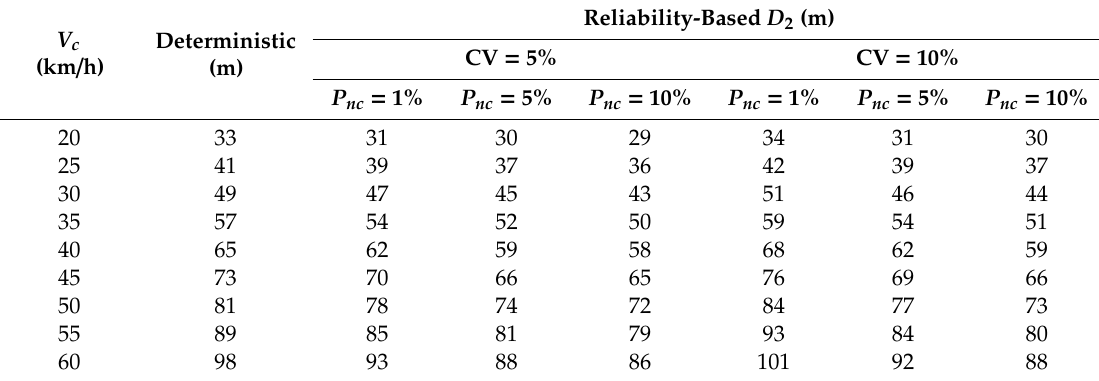
Table 5. Reliability-based design values of the required sight distance for circulating vehicle D 2 . V